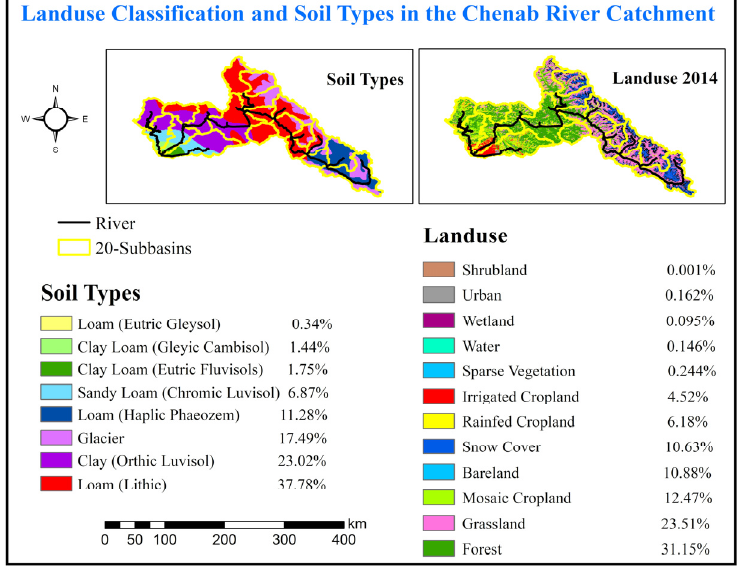
Figure 2. Landuse of the European Space Agency and the Harmonized World Soil Database for the transboundary Chenab River